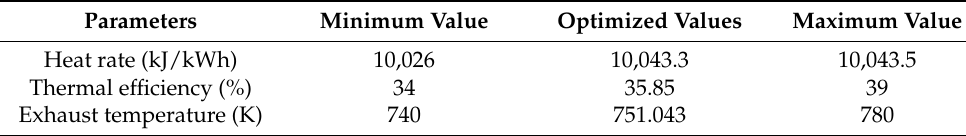
Figure 3. High-pressure compressor scaled map.